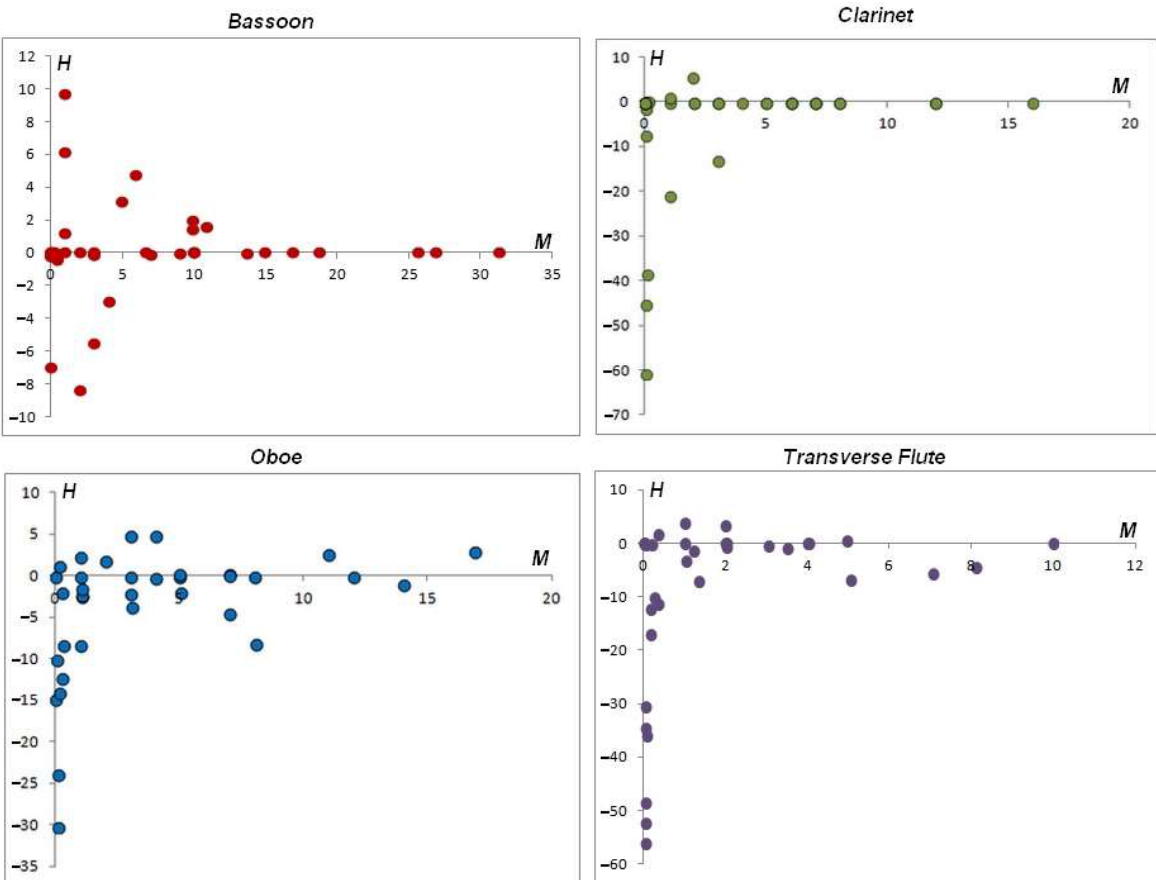
Figure 17. Two-dimensional representation in the H – M plane of the timbral space of the coefficients for the selected aerophones.